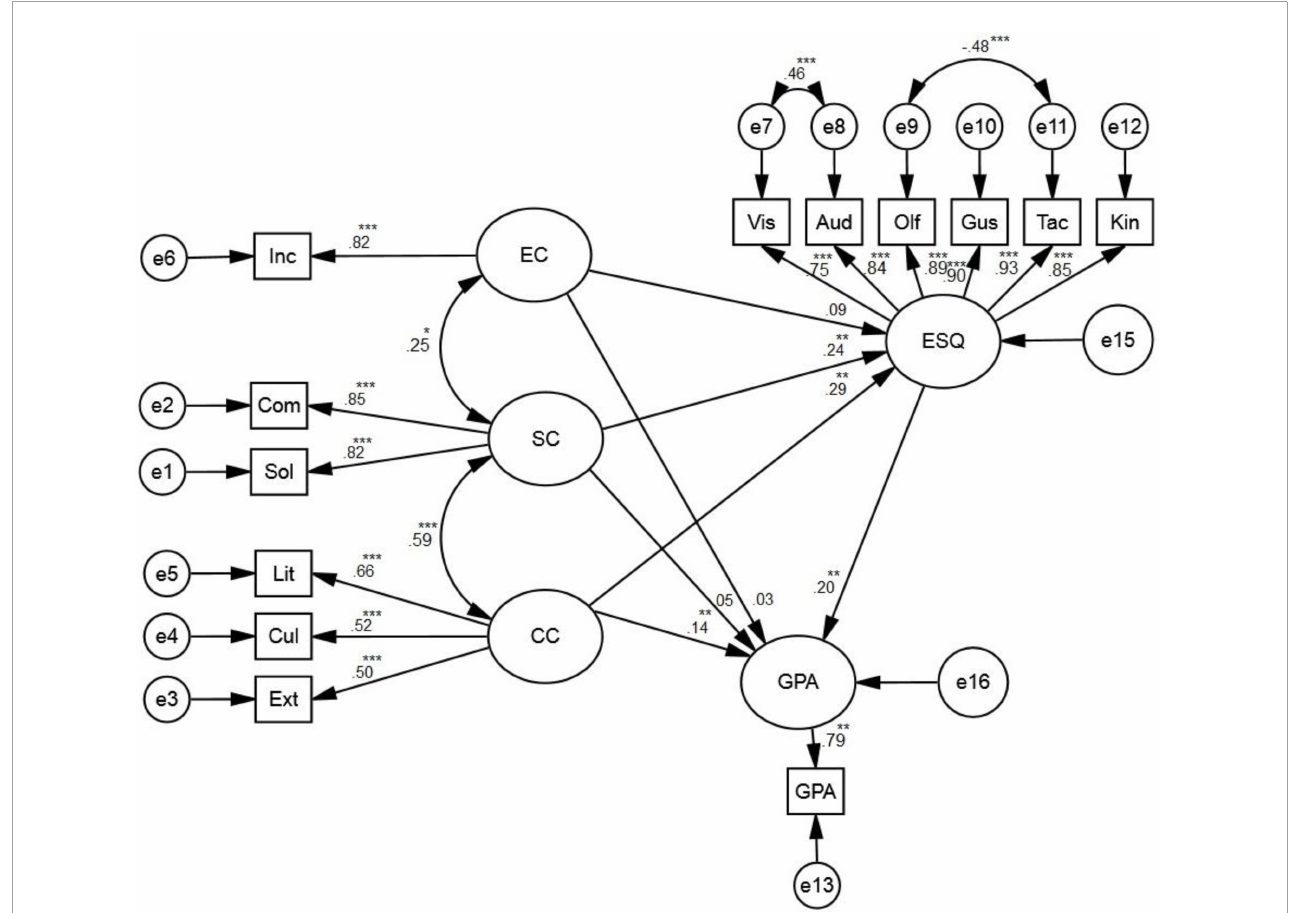
FIGURE1 The schematic relationships among academic achievement, economic capital, cultural capital, social capital, emo-sensory quotient, and grade point average (GPA). *Significant at p -value = 0.05. **Significant at p -value = 0.01. ***Significant at p -value < 0.001.